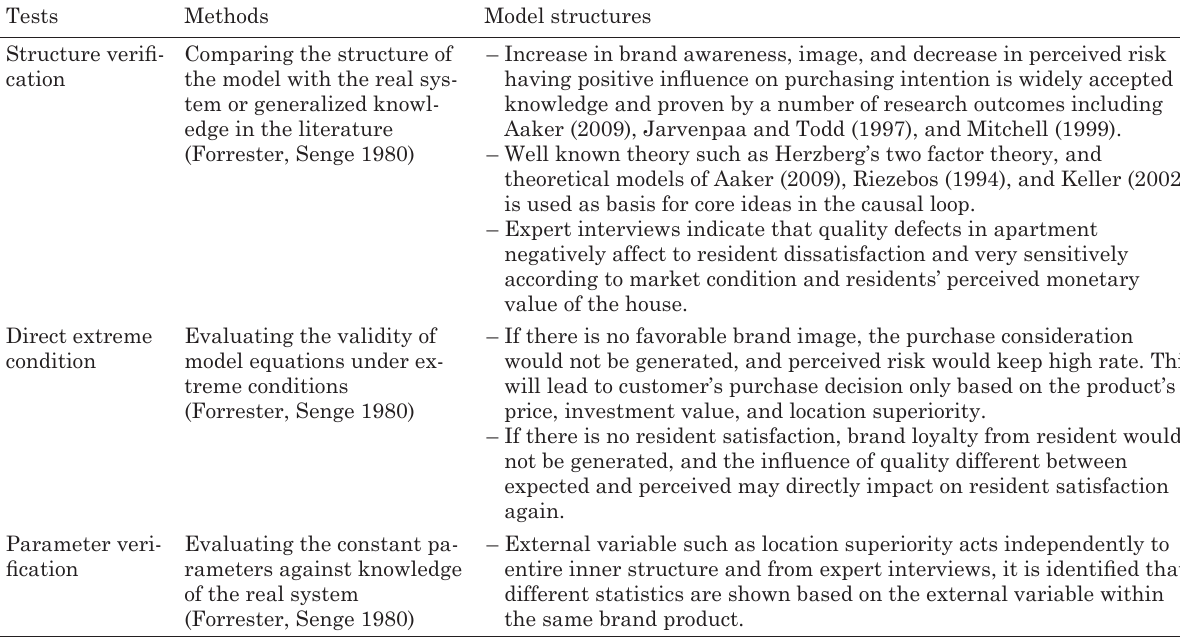
Table 3. Structure verification tests for the proposed